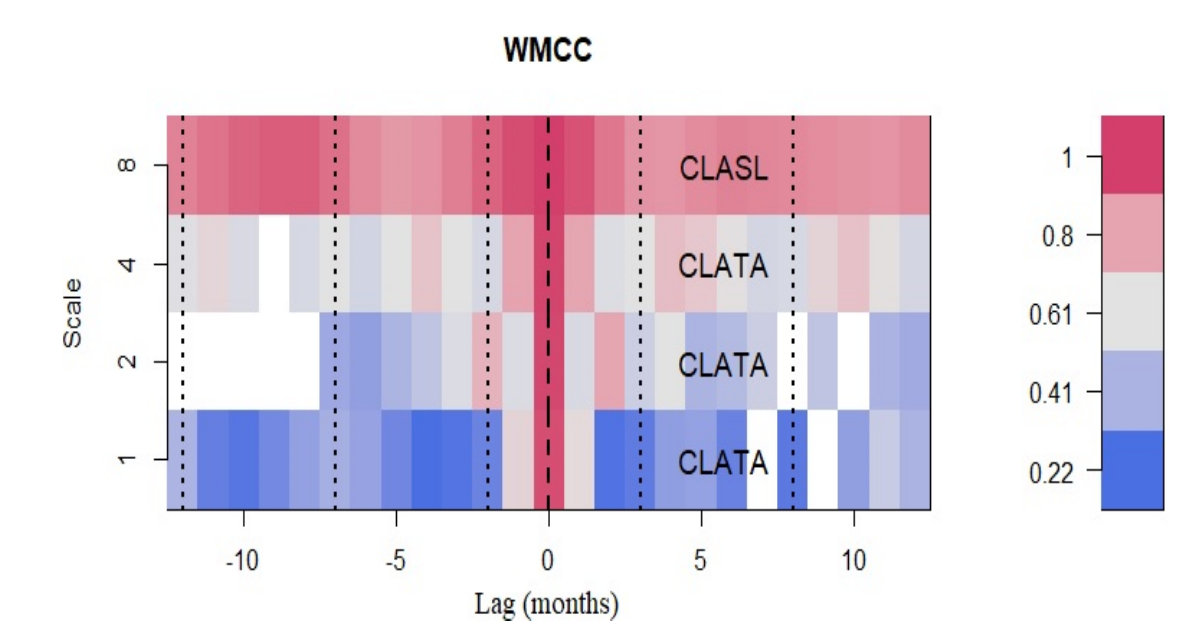
Figure 9. WMCC GSE and banking sector financial soundness. Table 3. WMCC GSE and banking sector financial soundness.